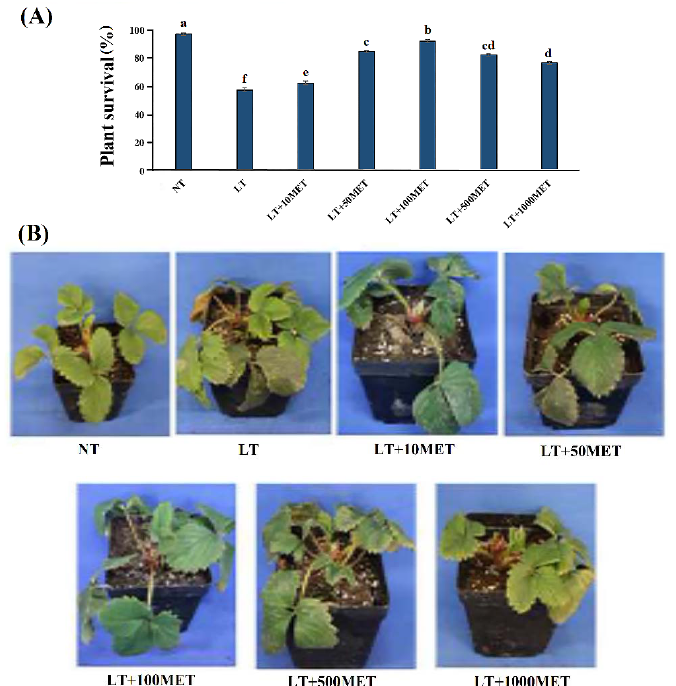
Figure 1. Effects of exogenous application of melatonin on plant survival (%) ( A ) and growth ( B ) of strawberry seedlings under cold stress. Plants treated with distilled water under the normal conditions (25 ◦ C) served as control (NT). The strawberry seedlings were pretreated with distilled water (LT), 10 µ M melatonin (LT + 10MET), 50 µ M melatonin (LT + 50MET), 100 µ M melatonin (LT + 100MET), 500 µ M melatonin (LT + 500MET), and 1000 µ M melatonin (LT + 1000MET) 3 times in a two-day interval and then exposed to cold stress for 2 days. Graphs represent the mean of three biological replicates. Values labeled with different letters indicate significant differences among treatments at ( p ≤ 0.05) by LSD.